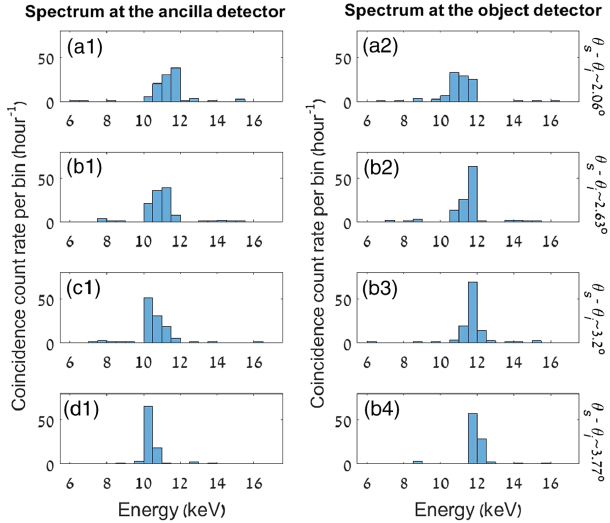
FIG. 4. PDC spectra for the ancilla (left plot) and object detector (right plot) for angular separation between the detectors of (a1, a2) 2.06°, the degenerate case, (b1, b2) 2.63°, (c1, c2) 3.2°, and (d1, d2)